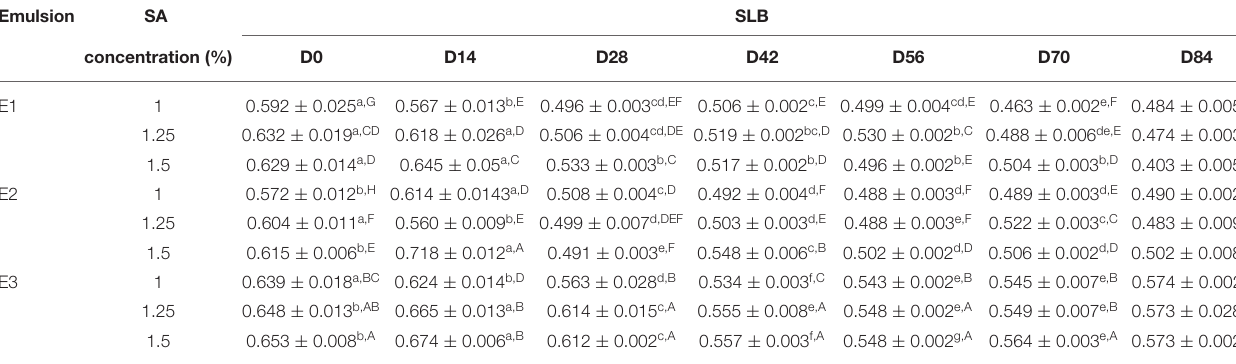
TABLE 2 | Solid liquid balance values of E1, E2, and E3 emulsions of different storage times. Emulsion SA SLB concentration (%)